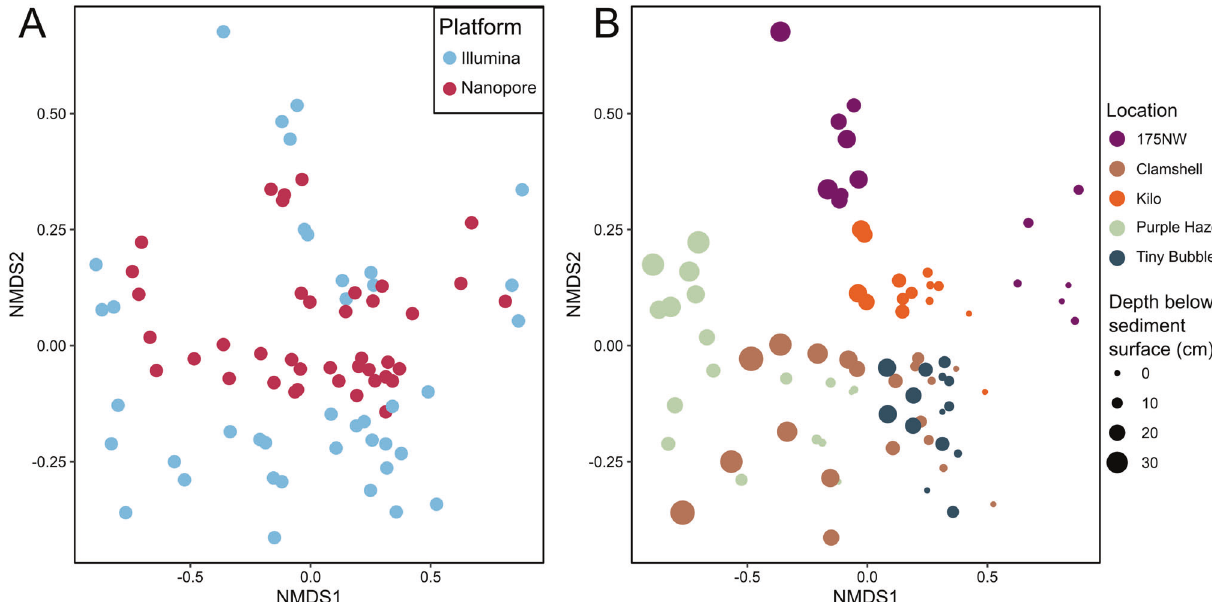
Fig. 5 NMDS plots with combined Nanopore and Illumina data sets. The same NMDS plots based on Bray-Curtis dissimilarity are shown with samples (points) colored and sized based on different parameters. A Sample color indicates sequencing technology. B Samples colored on location, with size proportional to depth below the sediment surface. Stress = 0.1. The Pearson correlation between phylotypes in the Nanopore and were unclassi fi ed at fi ner taxonomic levels in both Nanopore and Illumina data sets was 0.885 (Fig. S2A). Discrepancies in relative Illumina data sets (rendering comparisons arbitrary), we also abundances of taxa at different taxonomic levels were also performed comparisons using the highest level of taxonomic evaluated (Figs S2B, S3). At the genus level, Algorimarina accounted classi fi cation that was assigned to a sequence, i.e., its “ phylotype ” .